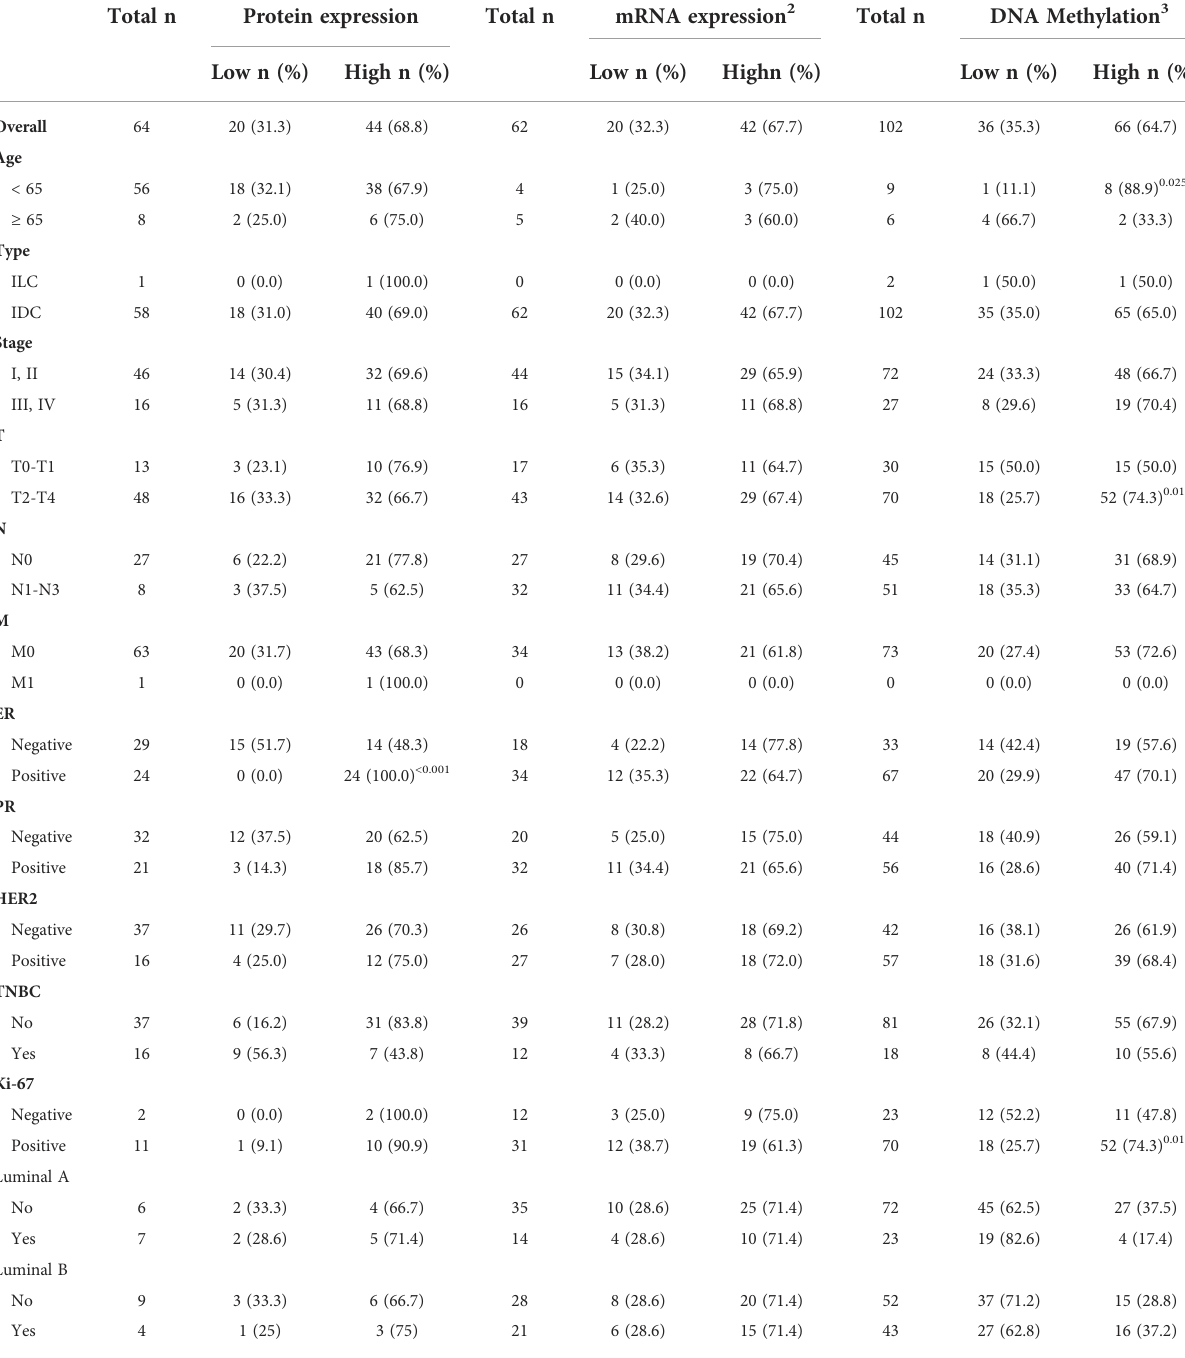
TABLE 1 TSTD1 protein expression, mRNA expression, and methylation levels in relation to the clinical parameters of Taiwanese patients with breast cancer 1 . Total